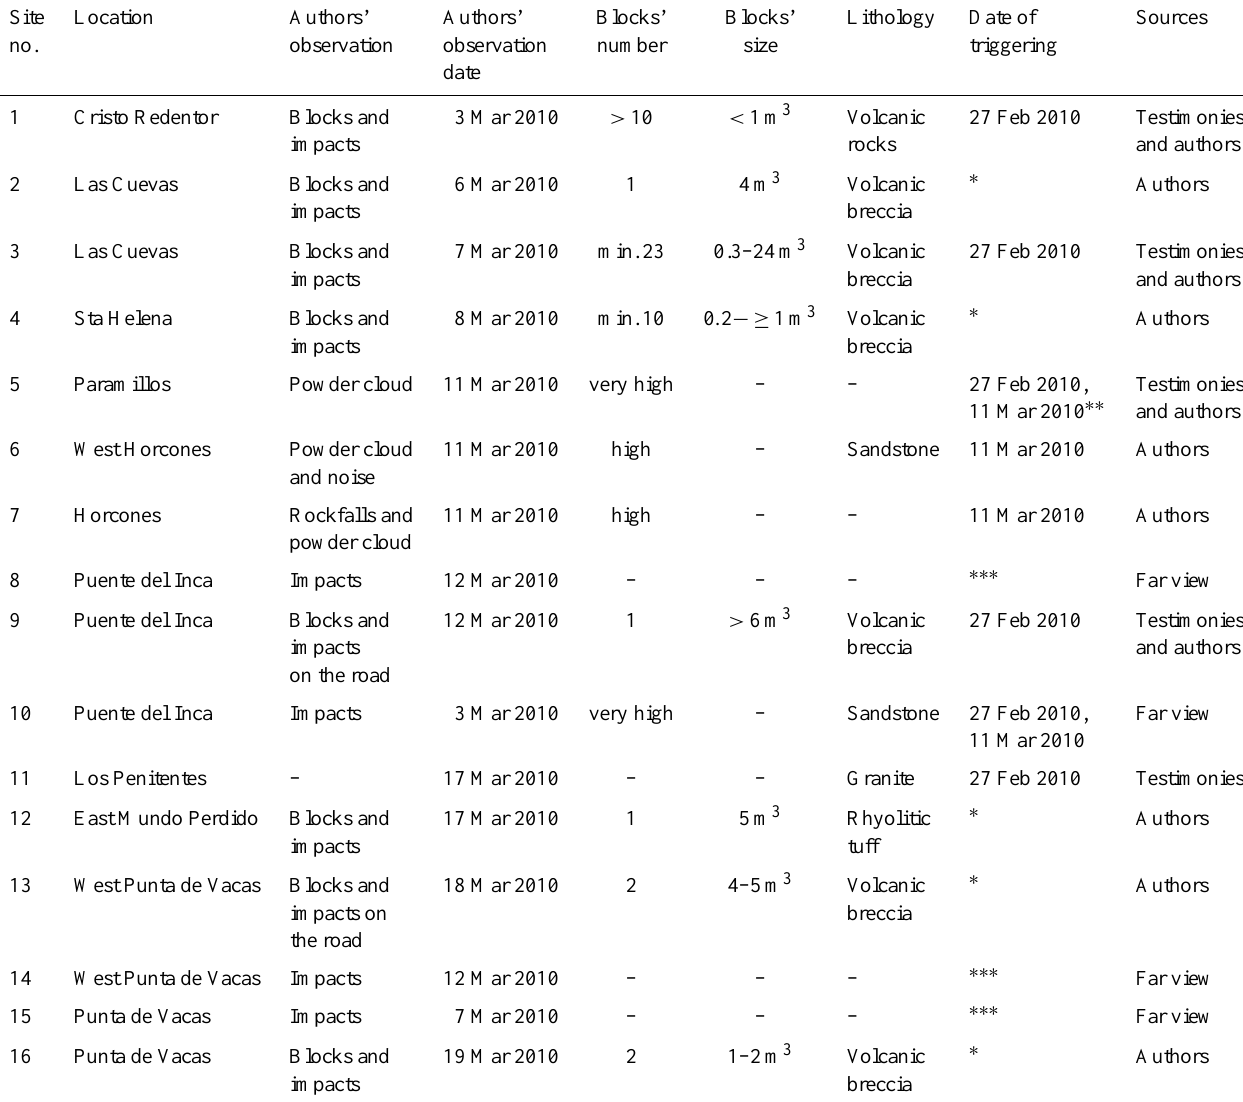
Table 1. Rockfalls observations for each site presented on Fig. 1. The rockfalls in the sites without date of triggering probably occurred between 27 February and 19 March 2010, for example due to the 28 February